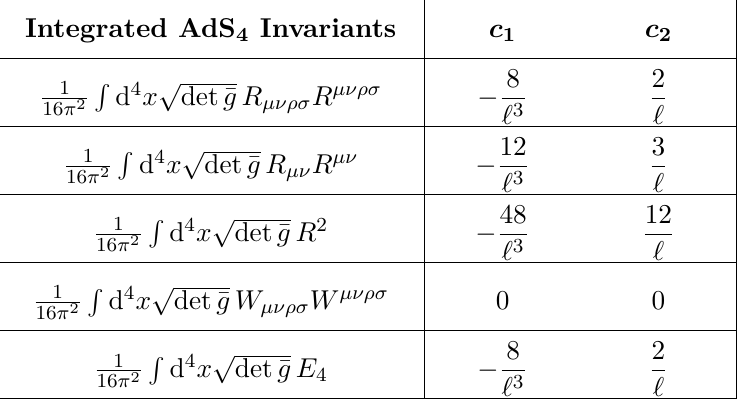
Table 4. Holographic renormalization data ( c 1 , c 2 ) for different integrated background invariants around the AdS 4 black holes for finite C local